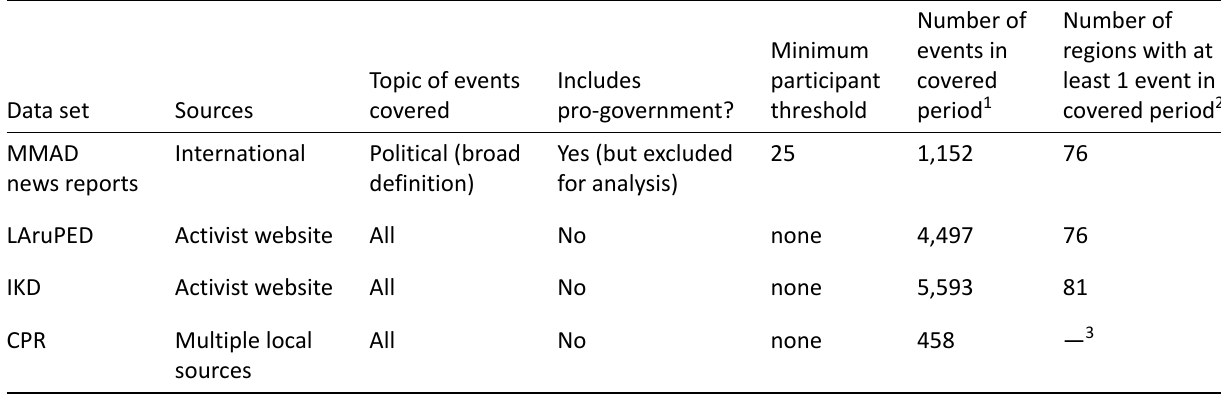
Table 1. Comparison of data sets used in